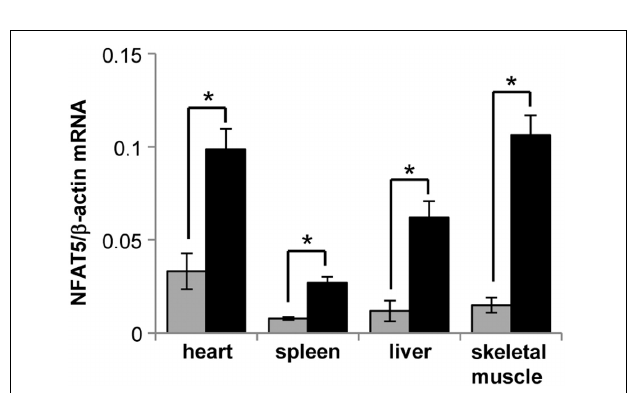
HSP70 by semiquantitative RT-PCR. Relative mRNA abundance was normalized to that of β -actin to correct for differences in RNA input. Data are means ± SEM for n = 4; ∗ P < 0 . 05. (B) Protein samples from renal cortex, outer medulla and inner medulla were tested for protein expression of NFAT5 and NFAT5 target genes AR and HSP70 by Western blot. To demonstrate comparable protein loading, the blots were also probed for actin. Representative blots from at least 4 independent experiments are shown.